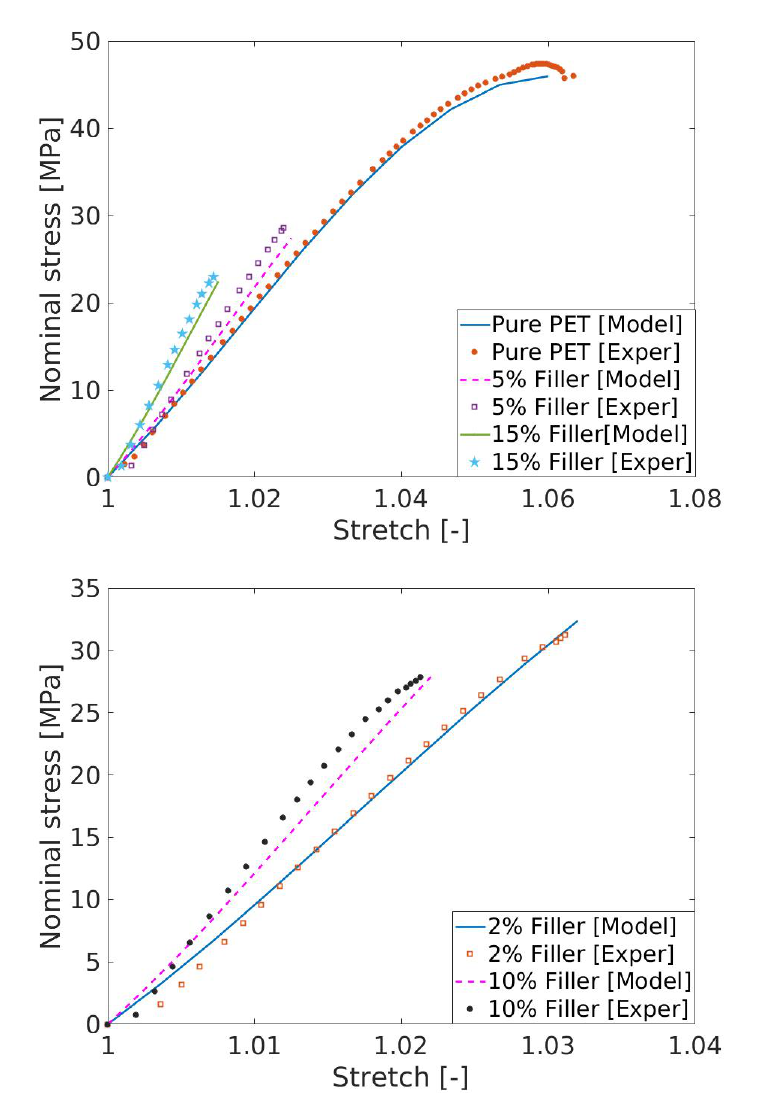
Figure 9. ( Top ) Model prediction with the nonlinear Carrol model 5% and 15% fillers; and ( Bottom ) model prediction with the nonlinear Carrol model for 2% and